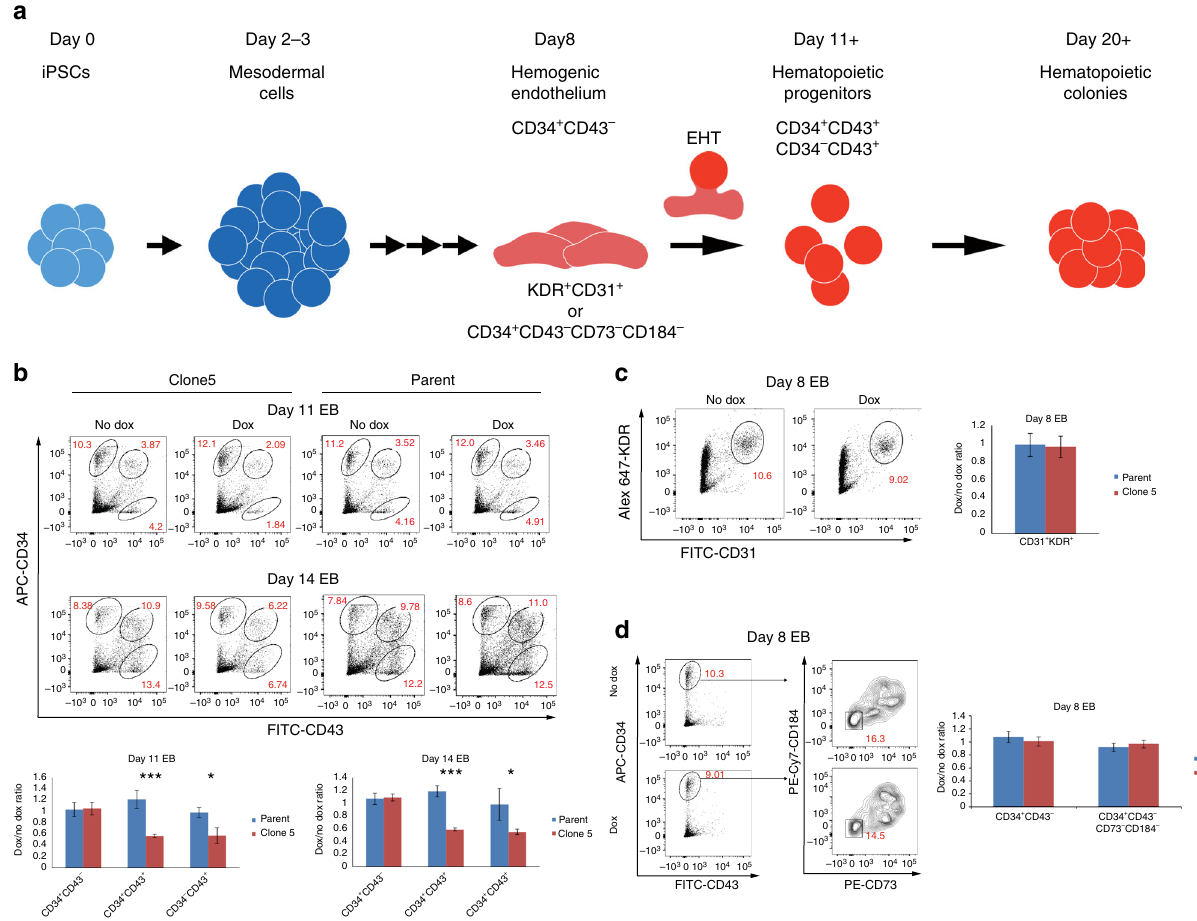
Fig. 4 Impact of trisomy silencing on hematopoietic populations during differentiation. a A simpli fi ed schematic of steps in the hematopoietic differentiation process with markers used to de fi ne speci fi c cell population. EHT: endothelial to hematopoietic transition. b Early hematopoietic progenitor populations detected at day 11 and 14 differentiation for clone 5. Quanti fi cations are represented as the ratio of doxcycycline-treated cells to untreated cells. Transgenic cells, which XIST is induced have less CD43 + early hematopoietic progenitor cells at both day 11 and 14 of differentiation. c , d Hemogenic endothelium-like populations identi fi ed during hematopoietic differentiation for clone 5. Quanti fi cations are represented as the ratio of treated cells to untreated cells. Chromosome 21 silencing does not affect the formation of hemogenic endothelium-like populations at day 8 of differentiation, using either of the two sets of markers to de fi ne this population. Error bars represent s.e.m. from fi ve independent experiments and P values were calculated by Student t test; * P < 0.05, *** P <